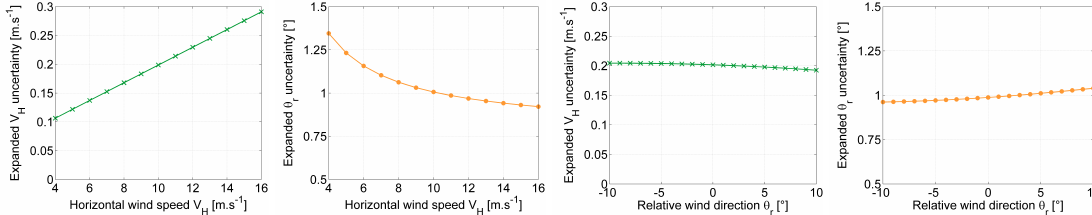
Figure 13. Expanded uncertainties U V